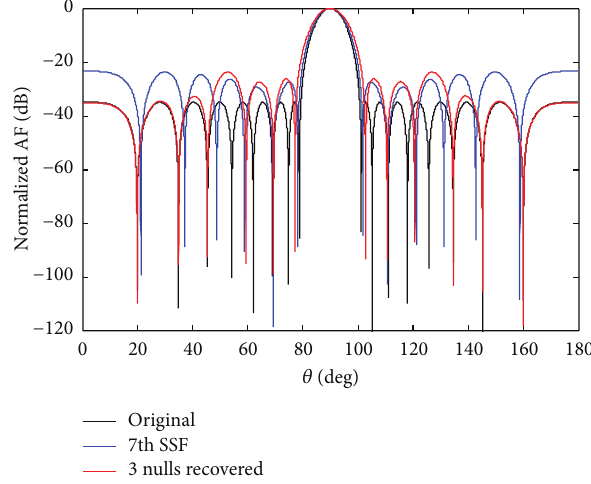
Figure 9: The original radiation pattern, the 𝑤 7 SSF, and recovery of three nulls.